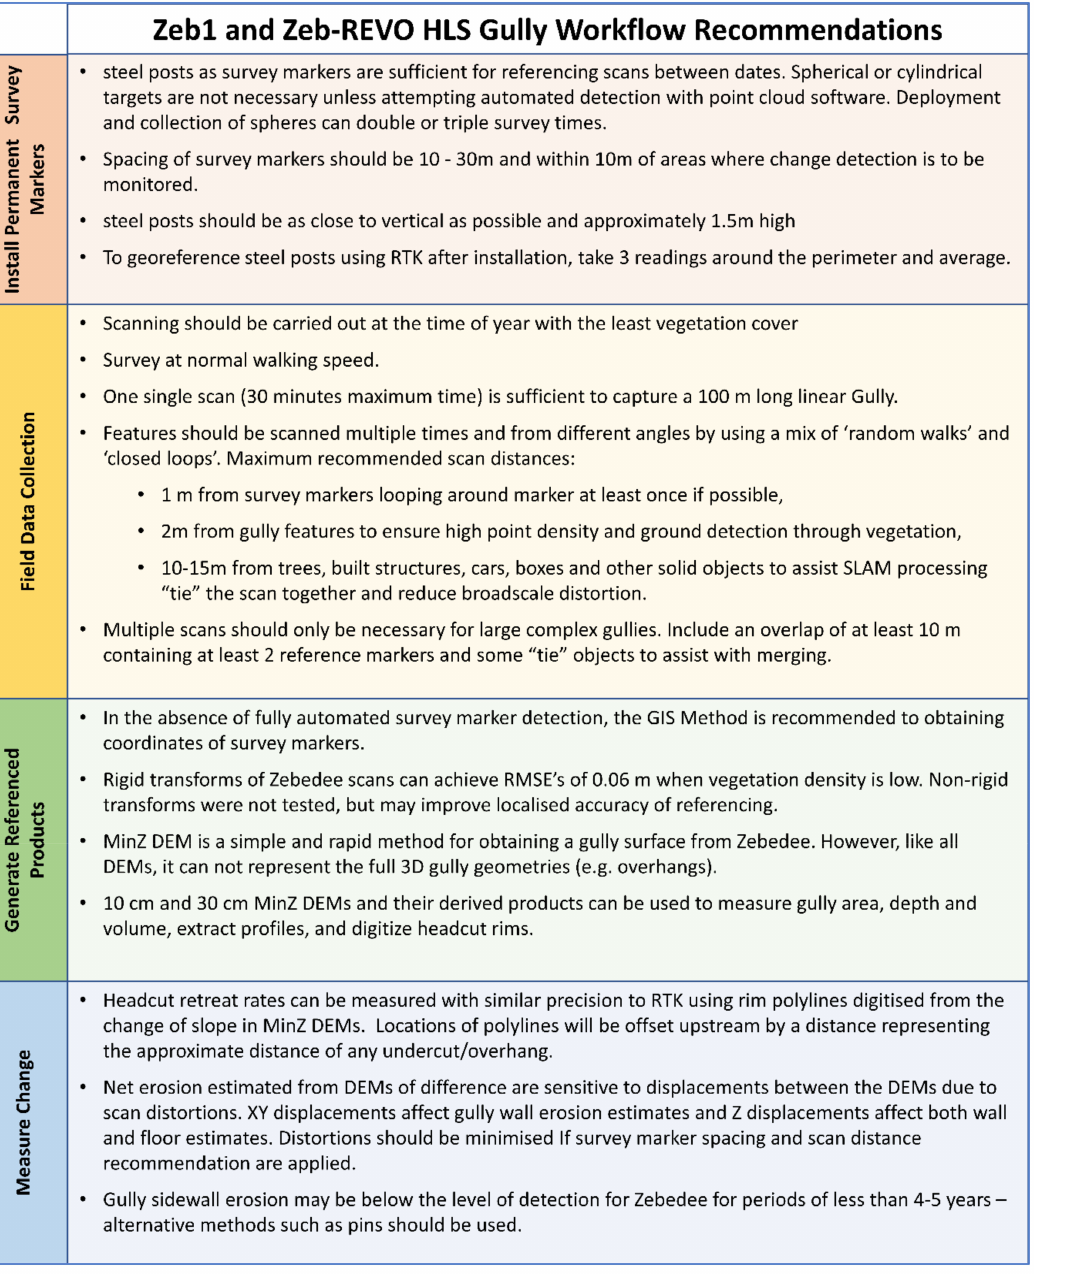
Figure 10. Recommendations for the application of HLS workflow to gully monitoring (Figure